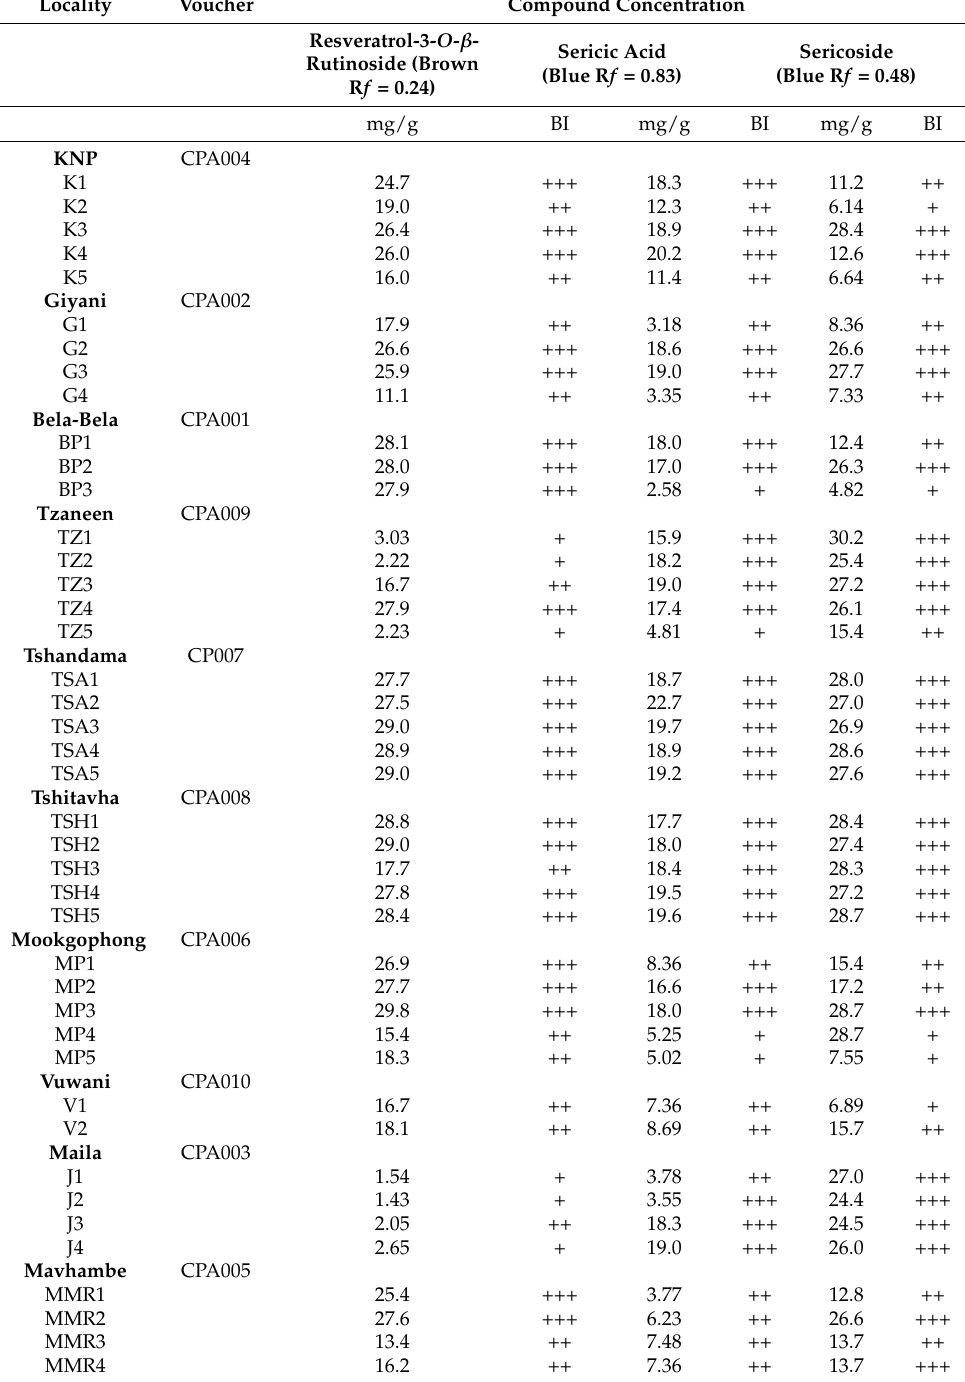
Table 1. Sample concentration with band intensity (Key: faint (+), intense (++), very intense (+++)). The quantitative values for the samples were determined using ultra-performance liquid chromatog- raphy with photodiode array detection. The localities where samples were collected are listed, as well as their assigned voucher specimen